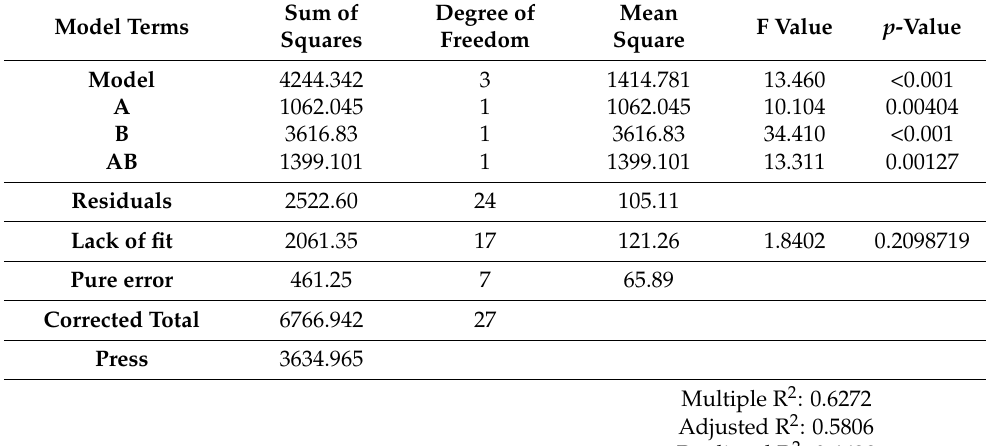
Table 4. ANOVA and regression analysis summary for the thin-walled tubes’ hole